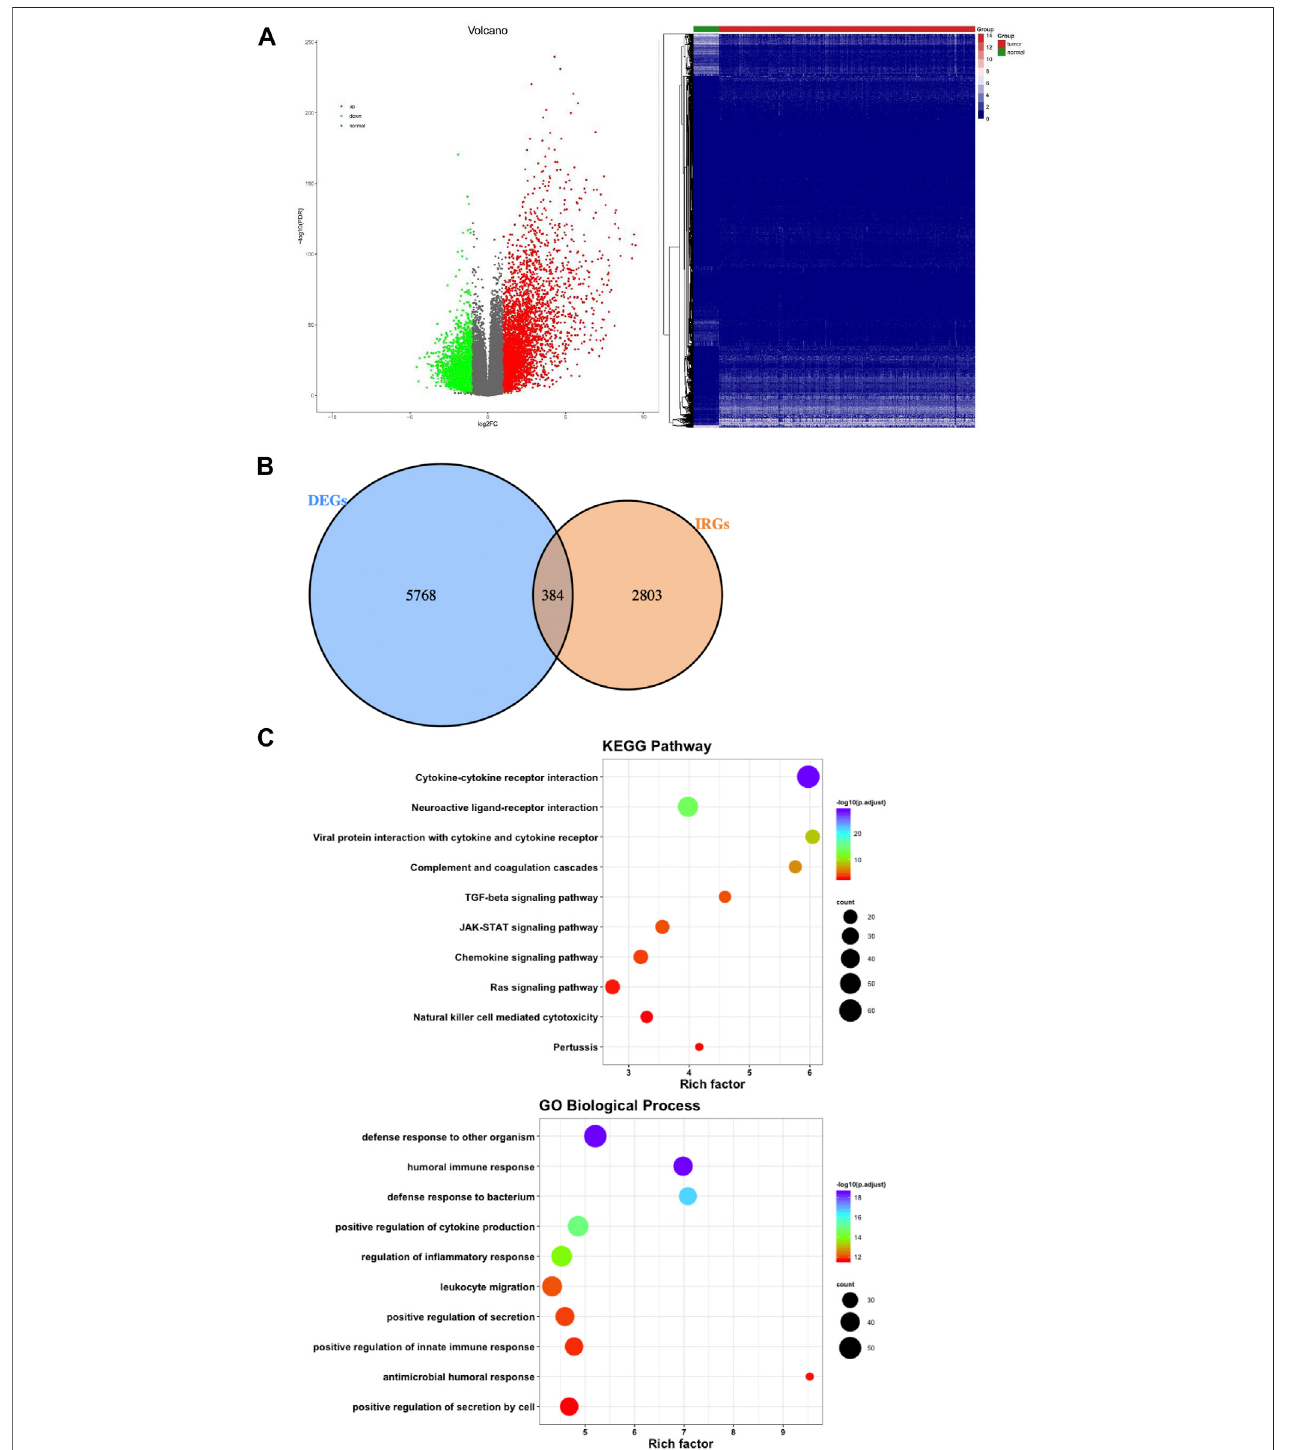
FIGURE 2 | Differentially expressed genes and functional enrichment analysis of differentially expressed IRGs. (A) Volcano plot and heatmap demonstrating differentially expressed genes between lung squamous cell carcinoma (LUSC) and nontumor tissues. Green and red dots represent differentially expressed genes, and gray dots represent genes that were not differentially expressed. (B) Venn diagram shows the common differentially expressed genes and immune-related genes. (C) Signi fi cantlyenrichedKEGGpathwaysandenrichedGOtermsbasedonbiologicalprocesses.GO=geneontology,IRGs=immune-relatedgenes,KEGG=Kyoto Encyclopedia of Genes and